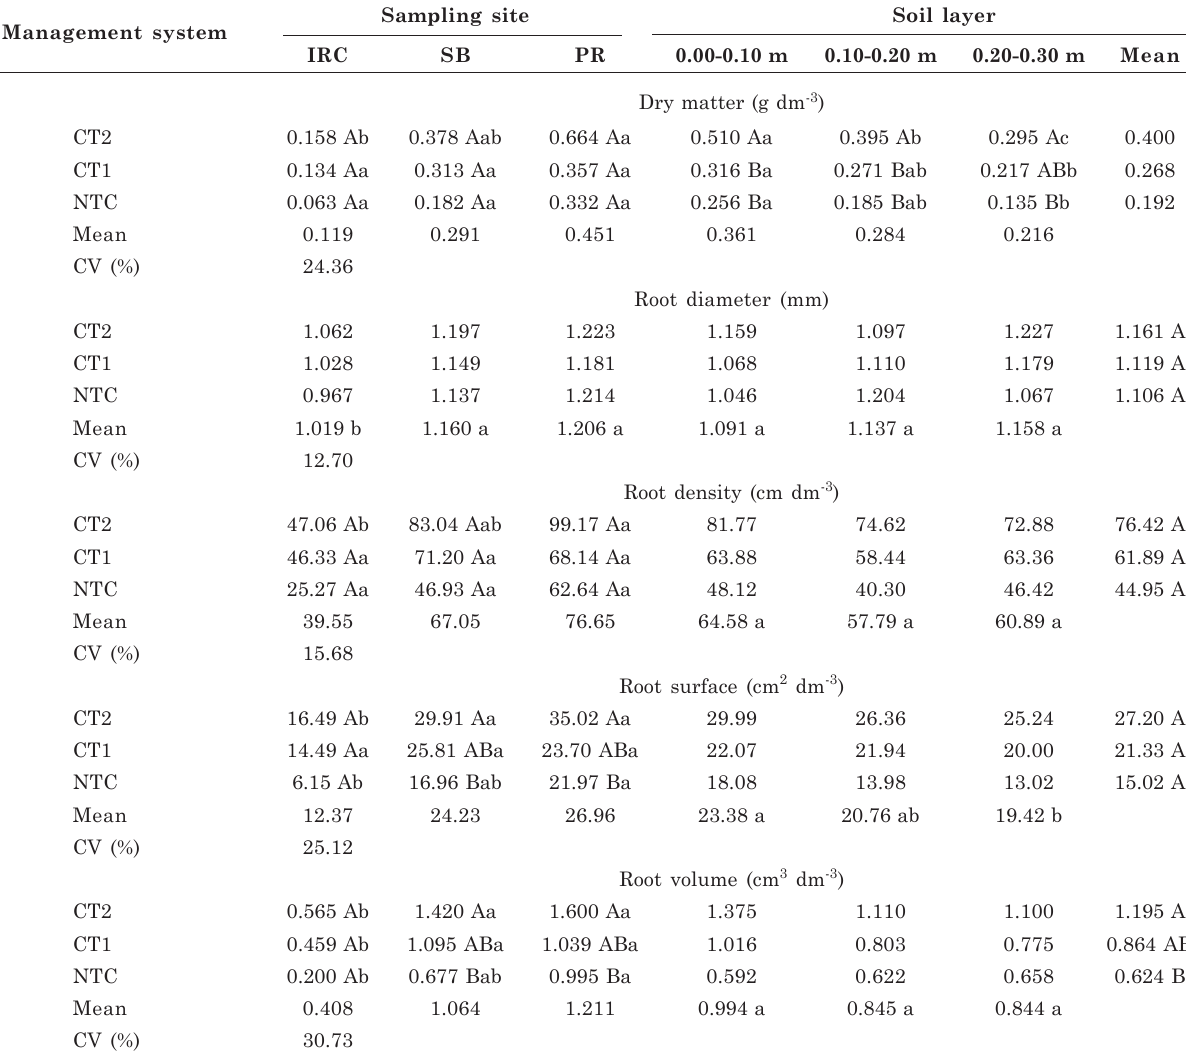
Table 4. Sugarcane root system under managements with traffic control consisting of the adjustment of the track width and use of an autopilot (TC2) and only adjusted track width (TC1) and no traffic control (NTC) measured in the plant row (PR), inter-row center (IRC) and seedbed (SB), in the studied